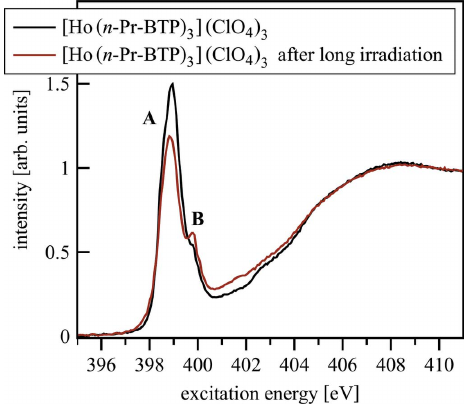
Figure 17 The effects of radiation damage in [Ho( n -Pr-BTP) 3 ](ClO 4 ) 3 N K -edge spectra after irradiation of the samples.